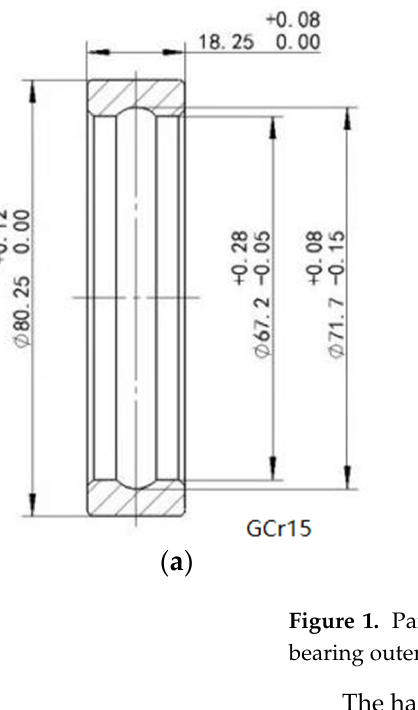
Table 1. Bearing outer ring elliptical deformation measurement results in the experiment (mm). Table 2. Bearing outer ring outer surface hardness results in the experiment